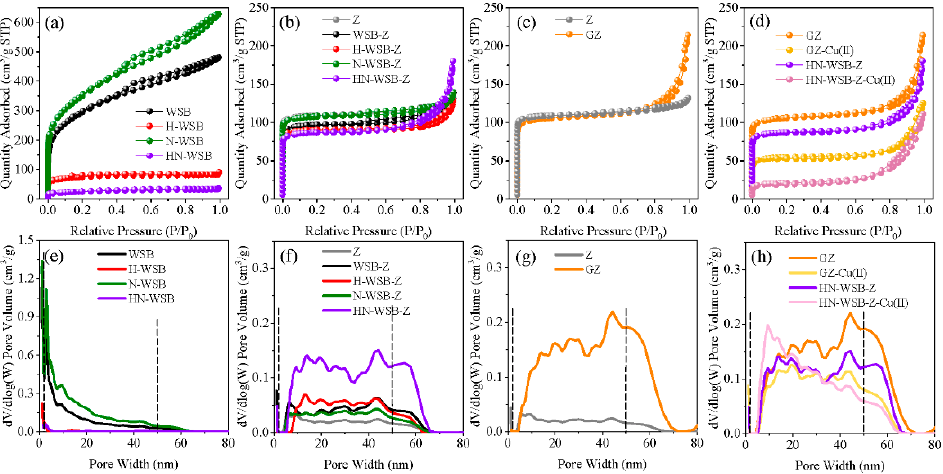
Figure 1. The N 2 adsorption–desorption isotherm of different biochars ( a ), different biochar composite FAUs ( b ), GO composite FAU ( c ), composite FAUs after adsorbing Cu(II) ( d ), and the corresponding pore-size distributions ( e – h ).